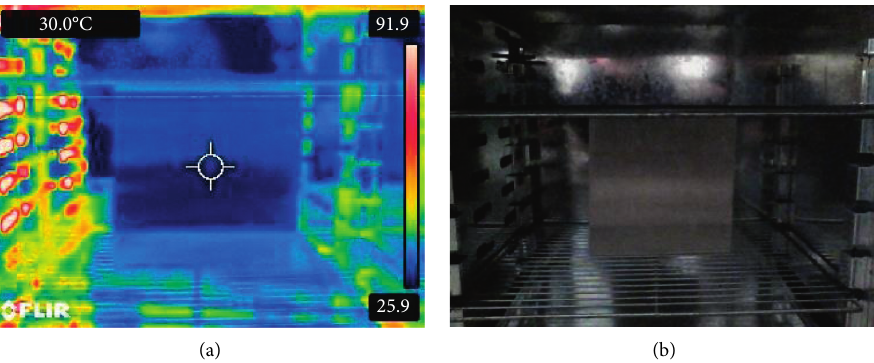
Figure 12: Experimental cooling of hot air heating for the electro-magnesium alloy without cathodic protection.